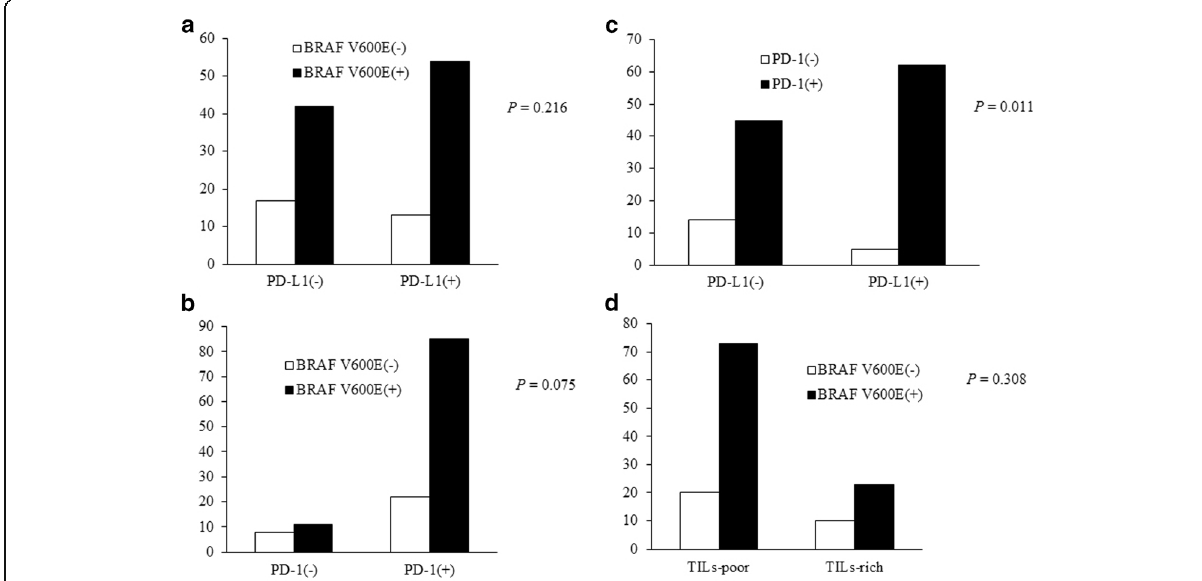
Fig. 2 a , The correlation between BRAF V600E and PD-L1 expression; b , The correlation between BRAF V600E and PD-1 expression; c , The correlation between PD-L1 and PD-1 expression; d , the correlation between BRAF V600E expression and tumor-infiltrating lymphocytes (TILs)